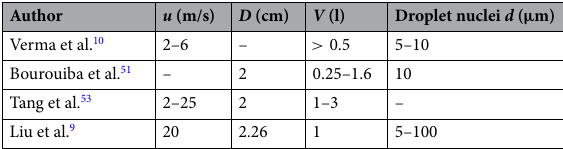
Table 1. Flow conditions for cough in